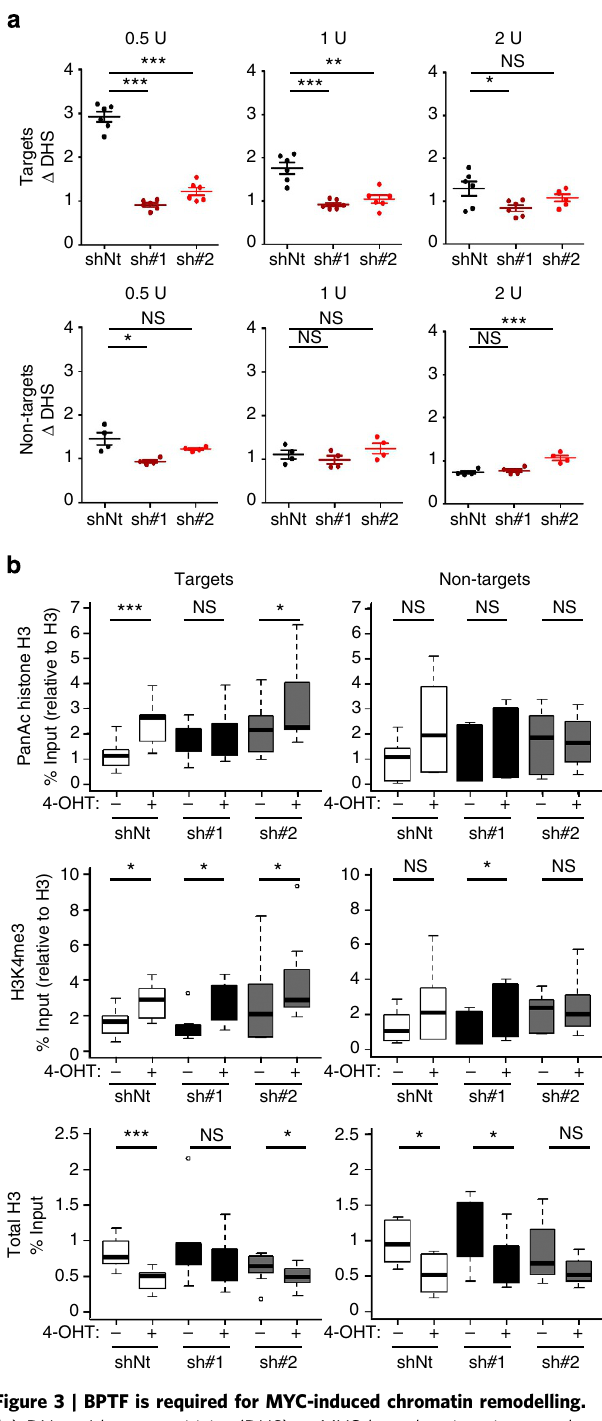
Figure 3 | BPTF is required for MYC-induced chromatin remodelling. ( a ) DNase I hypersensitivity (DHS) at MYC-bound regions in control and BPTF-silenced HFF MYC-ER cells, determined by enzyme titration. Dots represent the average values of seven independent experiments. P values were determined using paired t -test. ( b ) ChIP analysis of Pan AcH3, H3K4me3 and total H3 levels at the promoter of ‘target’ and ‘non-target’ genes in control and BPTF-silenced HFF MYC-ER cells. Each gene was assayed in at least three independent experiments. ChIP values are expressed as % of input and normalized for total histone H3 (with the exception of total H3). P values were determined using paired t